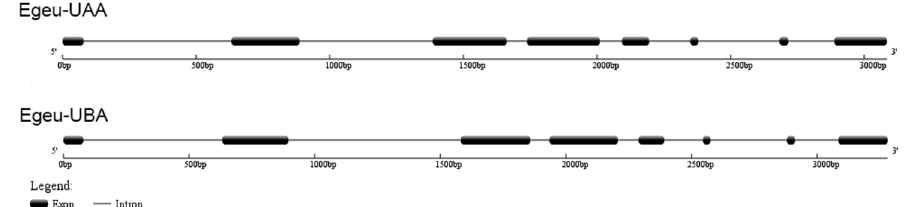
Fig 1. Schematic illustration of MHC class I genes in the Chinese